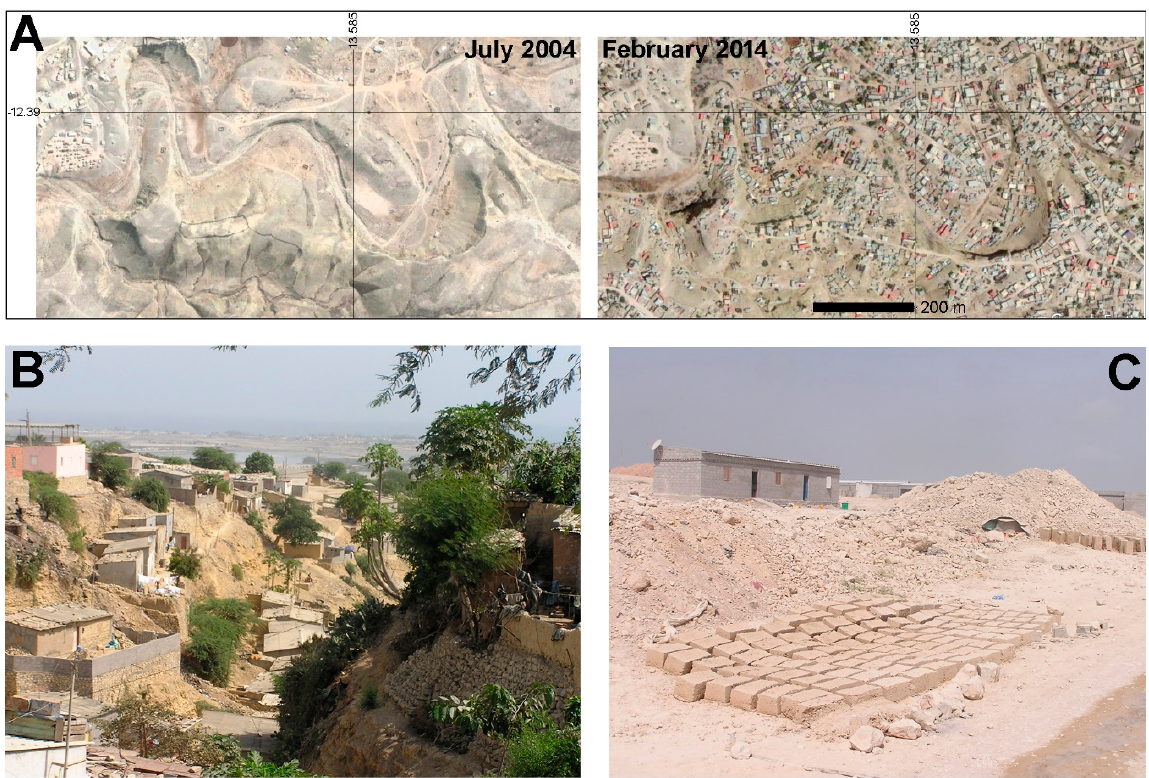
Figure 2. Human occupation in the dry valleys of coastal Benguela increased rapidly during recent decades. The catchment most affected by the flooding event of 2015 is a good example where the early 2000 s saw the appearance of many houses in coastal hills ( A ) Google Earth™ images. ( B ) Examples of the recent settlements in hills surrounding Lobito. ( C ) Adobe bricks, the cheapest and easiest to obtain construction material in the disordered burghs of Lobito and Catumbela.